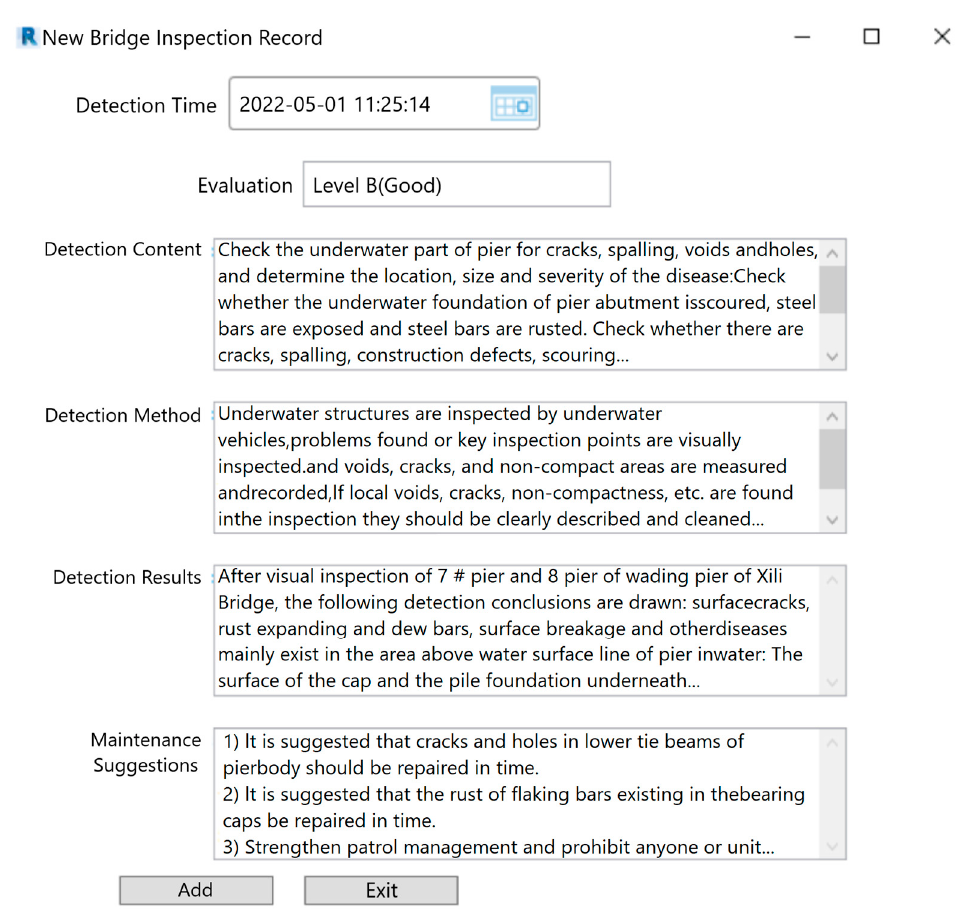
Figure 17. Bridge Underwater Structure Inspection Record